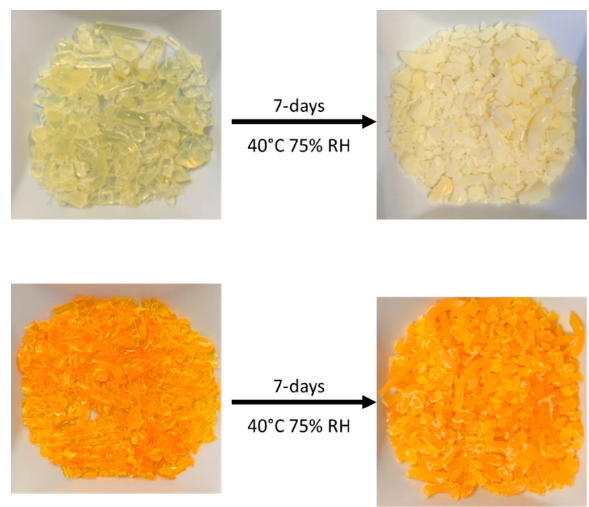
Figure 1. Haloperidol (top) and carbamazepine (bottom) hot melt extrusion (HME) before (left) and after (right) 7 days accelerated stability conditions as specified in the materials and methods section.